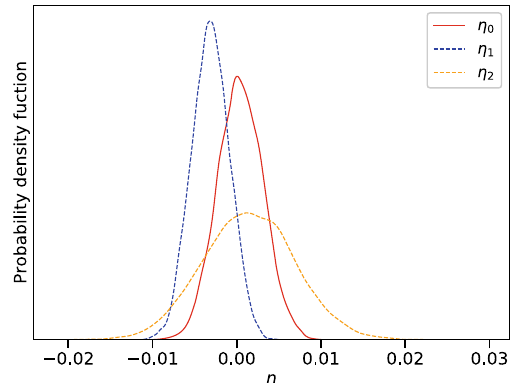
Fig. 3 Cosmic distance duality relation η( z ) for the GP reconstruction from the HII galaxy and compact radio quasar sample. The dashed line at unity is η( z ) = 1, the solid line is the ANN fit, and the shaded region is the 1 σ GP errors